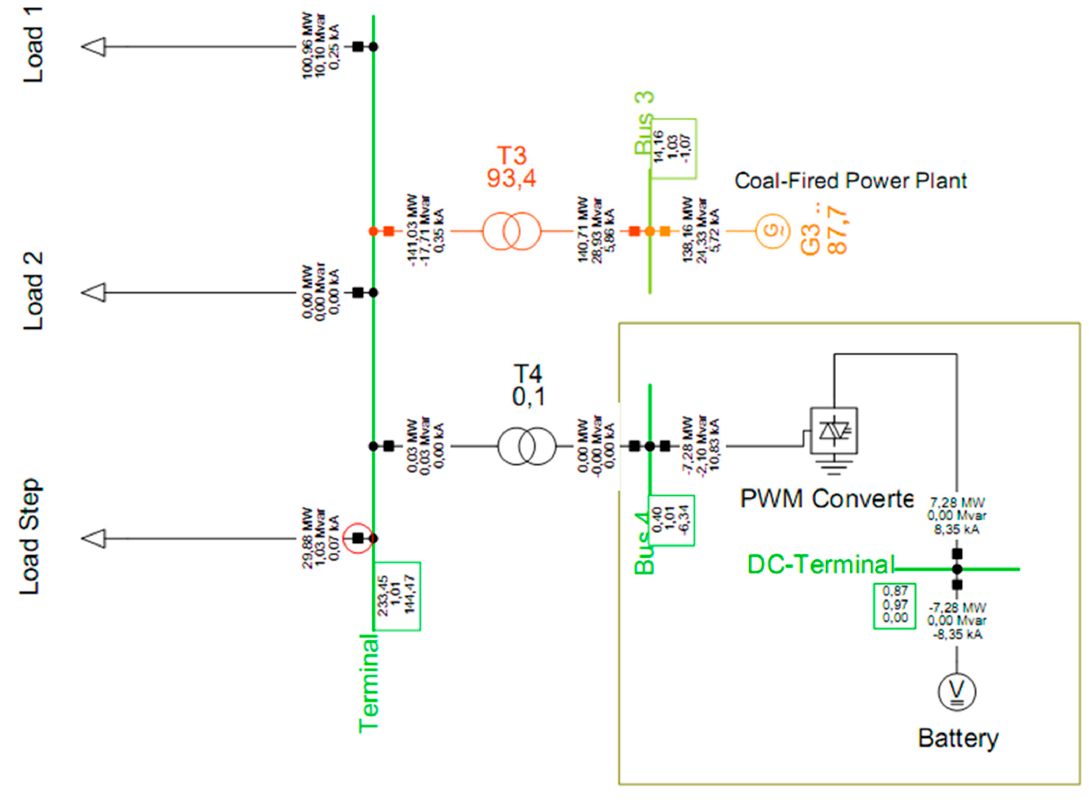
Figure 3. Test network for testing ESS.